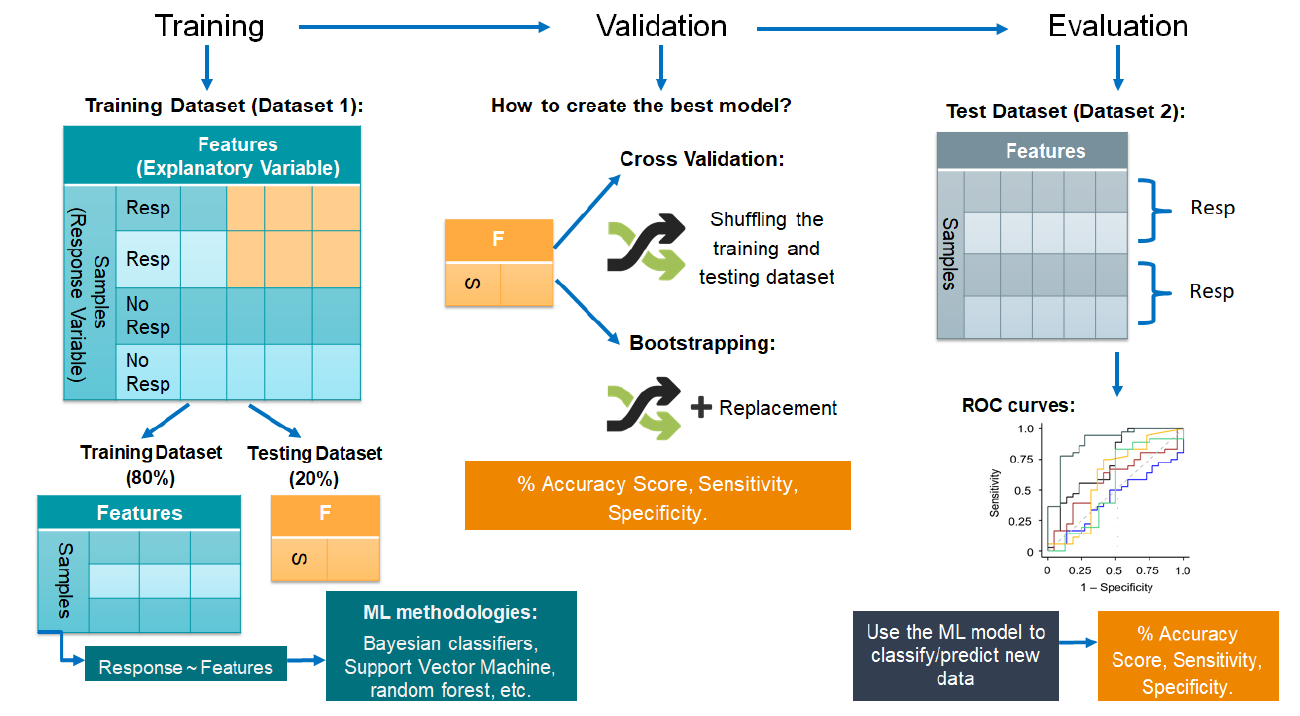
Figure 4. Schematic diagram of machine learning strategy. This schematic provides an overview of the distinct steps that are required for leveraging machine learning strategies for both the identification of candidate molecules and for their validation as biomarkers. The first step involves the assembly of a training dataset that contains concentrations of SPM in a cohort of patients with distinct outcomes for which a biomarker is sought. This dataset should contain a sufficient number of samples to allow for both the establishment of the dataset to be used to create the predictive models (using different machine learning strategies such us random forest) and the testing dataset. The latter should be employed to calculate how good the model is at predicting between conditions. During the validation step, the training and testing dataset are reshuffled several times using either cross-validation or bootstrapping (reshuffle with replacement) with the purpose of identifying the best predictive model and avoiding overfitting. When validation is completed, and the sensitivity and specificity of the model are calculated, biomarkers are identified, and the model can be evaluated using a new dataset. The evaluation of the model in an independent dataset is the most important step of the process since it confirms that the created model is sufficiently robust in predicting outcomes. Receiver operating characteristic (ROC) curves, among other accuracy tests, are used to evaluate the performance of machine learning